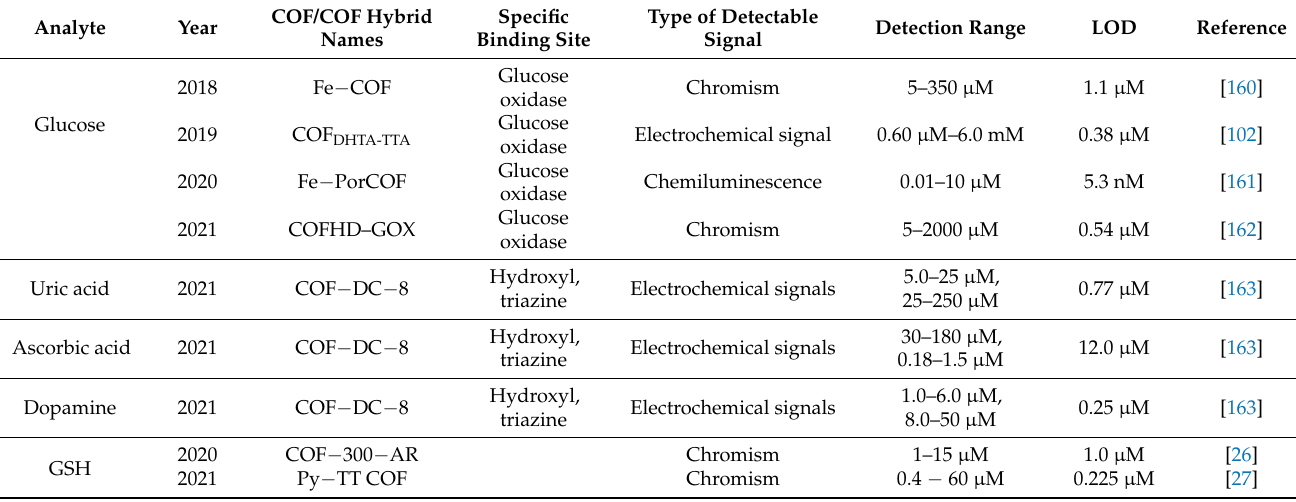
Table 8. COFs or COF-based hybrid materials for detecting glucose, uric acids, GSH, and other small